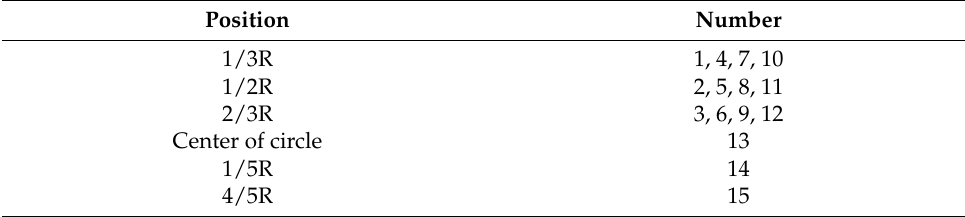
Figure 2. ( a ) prototype dimensions, ( b ) model dimensions and ( c ) model physical objects.